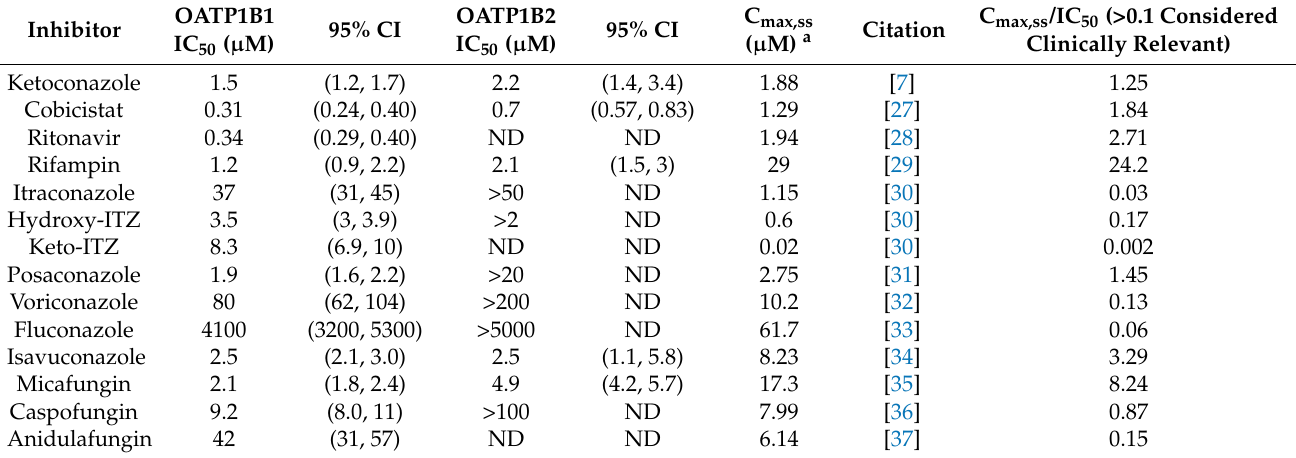
Table 2. The inhibition of OATP1B1 and OATP1B2 by antifungal drugs and potential clinical relevance.